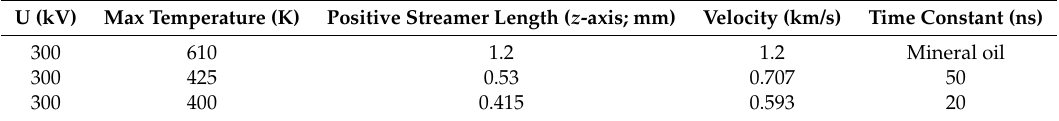
Figure 8. ( a ) Net space charge density, ( b ) distribution of electric field, ( c ) distribution of electric potential, and ( d ) temperature distribution along the z -axis from t = 0 to 1000 ns in intervals of 100 ns from the simulations in nanofluids with τ np = 20 ns. Table 4. Comparison between positive streamer propagation in mineral oil and mineral oil with